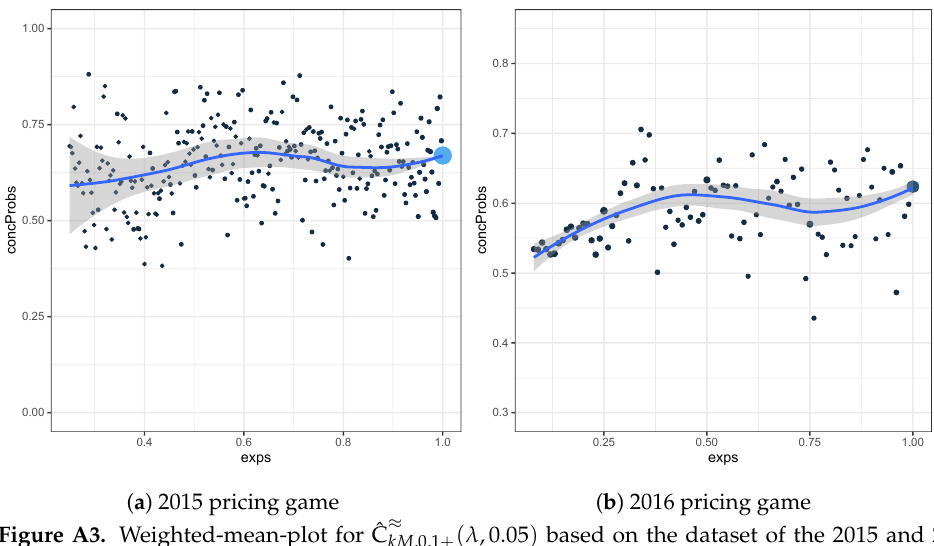
≈ ( λ ,0.05 ) based on the dataset of the 2015 and 2016 kM ,0,1 +